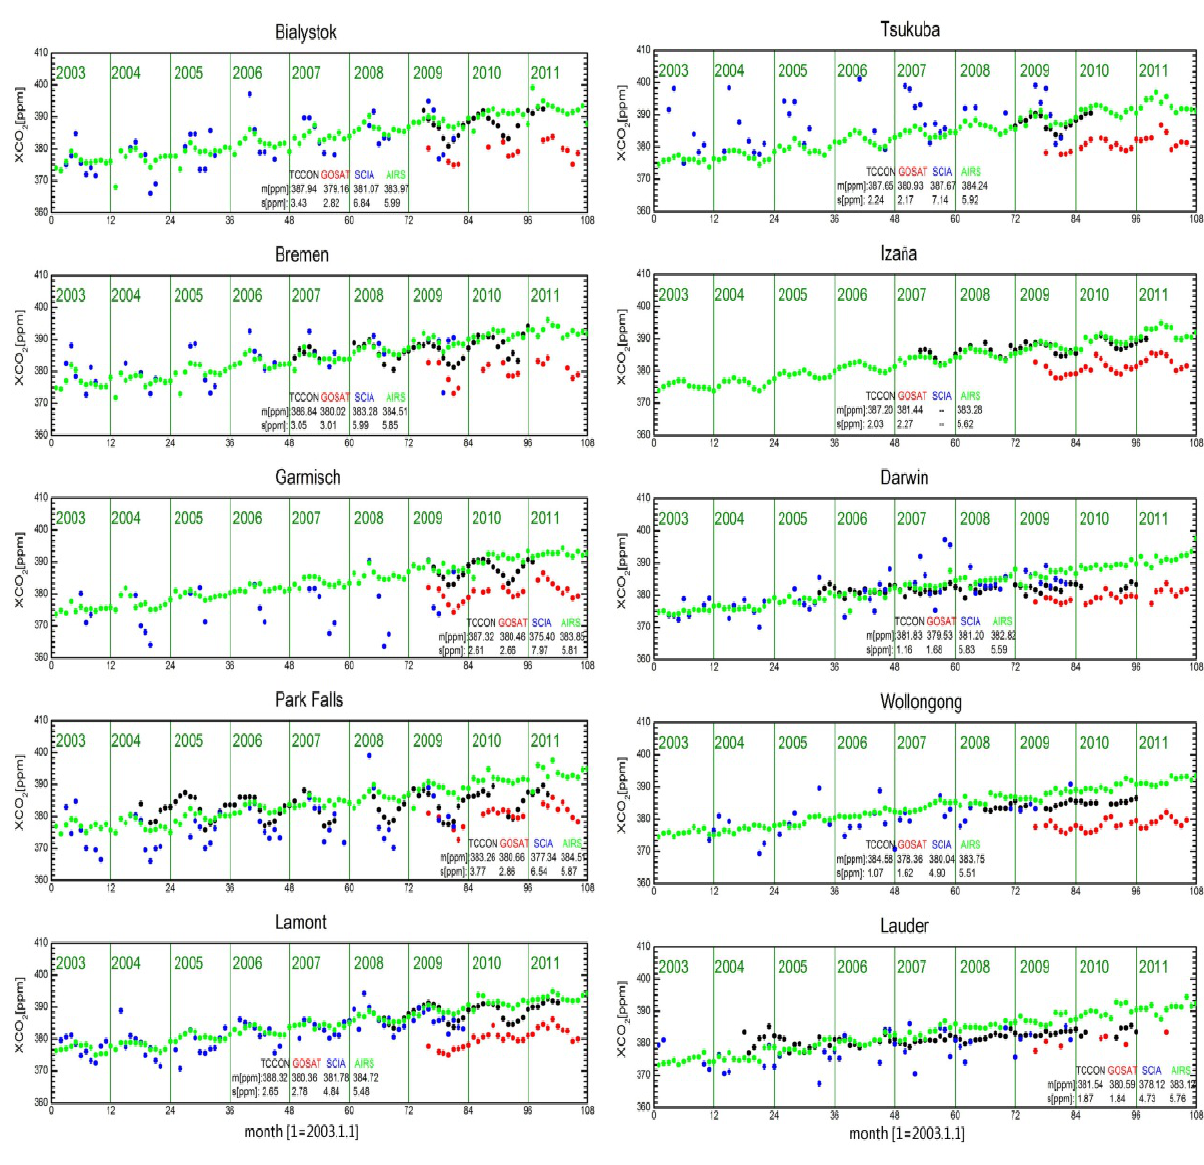
Figure 3. Comparison of the GOSAT (red), SCIAMACHY (blue) and AIRS (green) XCO time series of monthly means with g-b FTS measurements (black) at selected TCCON sites for the years 2003–2011. The following numbers have been computed based on the monthly averages: m is the mean vmr (in ppm) and s denotes the standard deviation of the monthly averages (in